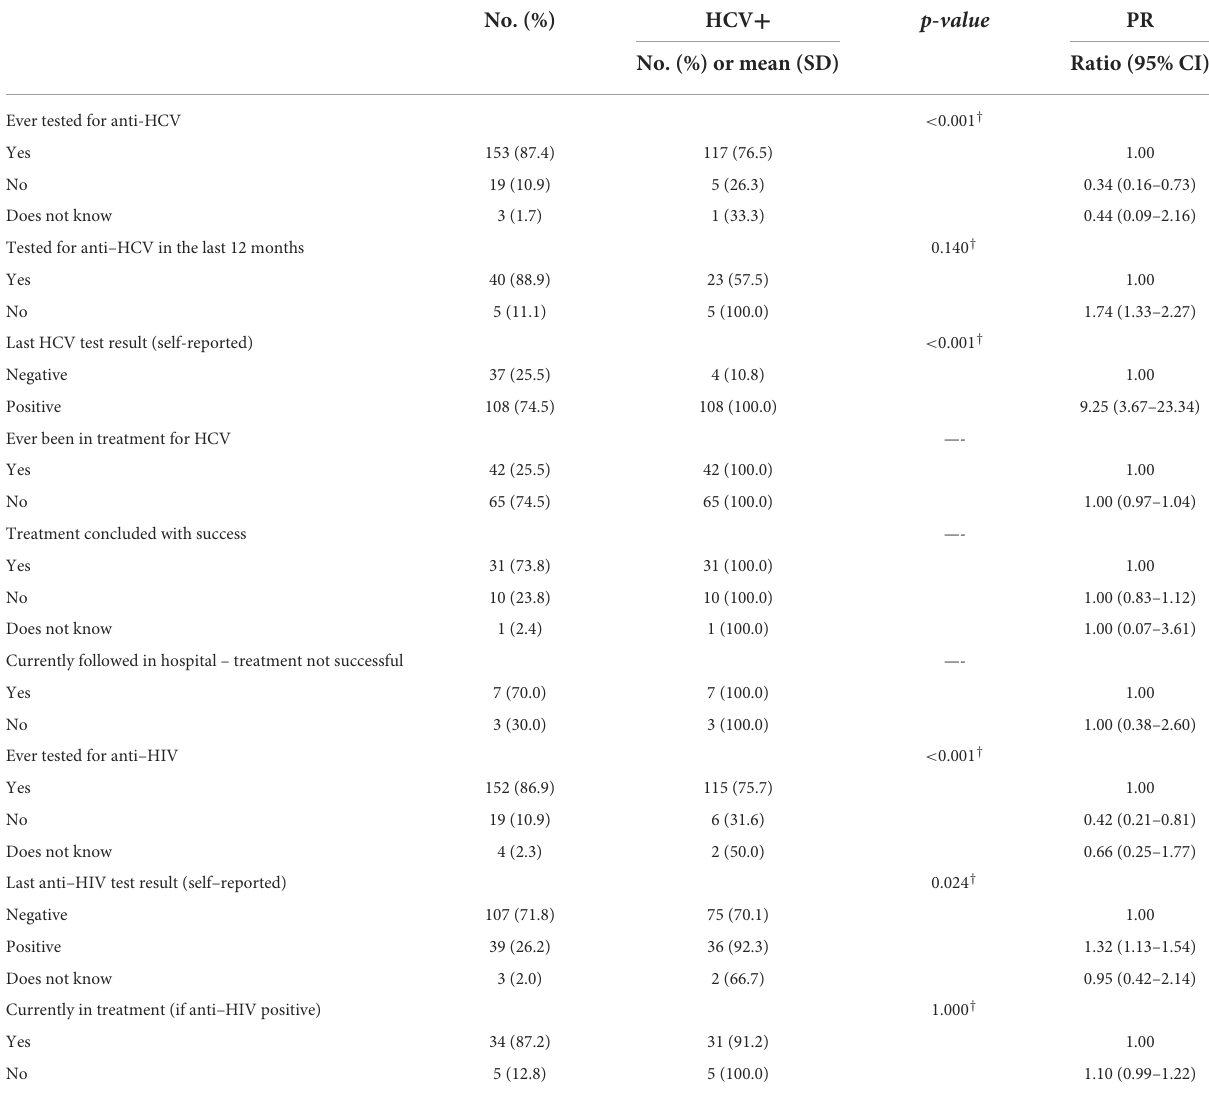
TABLE 4 Past anti-HCV testing, care, and treatment